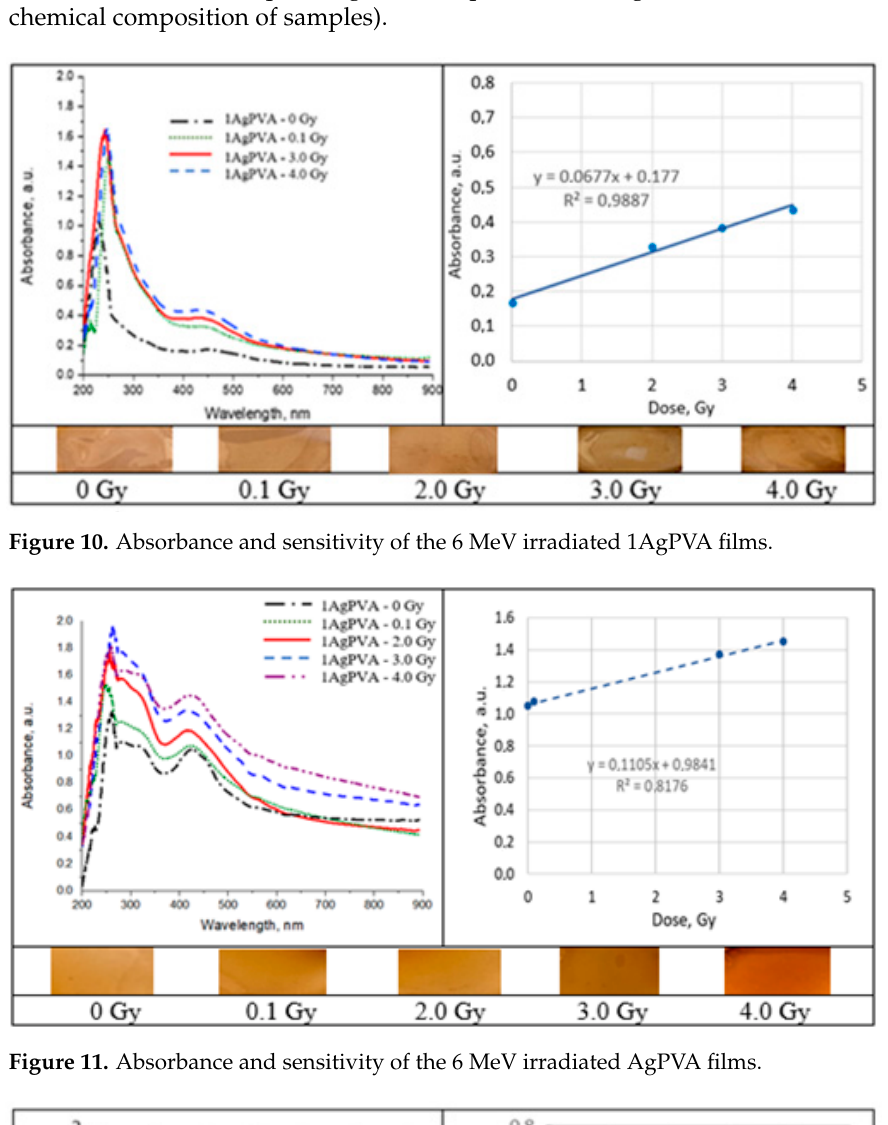
Figure 9. Color bleaching effect in irradiated investigated PVA-dye films. (Dose axis starts from 0.1 Gy.)